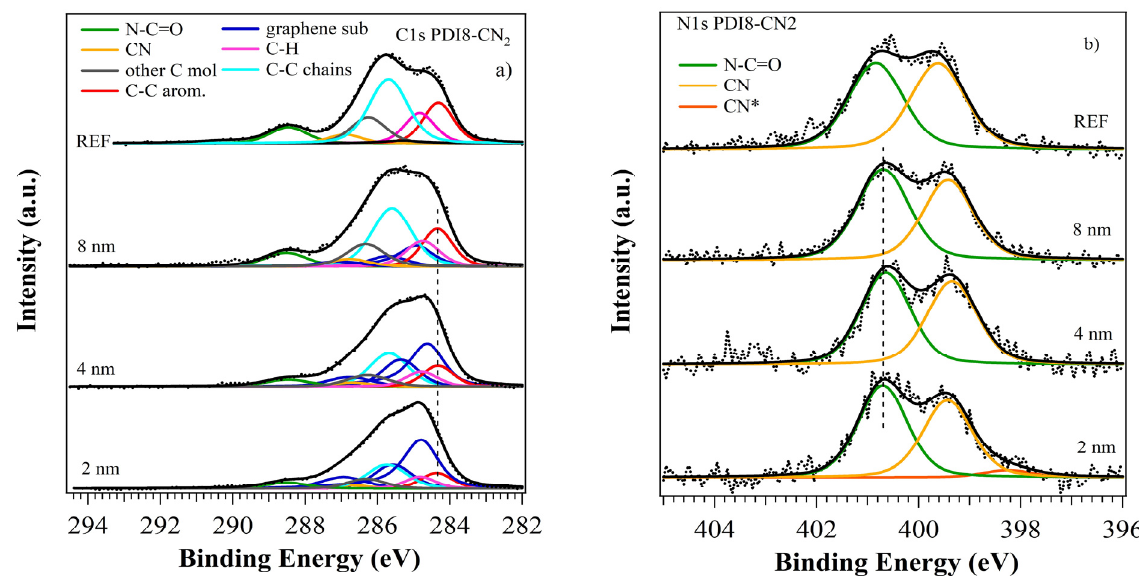
Figure 2. XPS analysis of the C1s ( a ) and N1s ( b ) core levels of the PDI8-CN2 film deposited on graphene, at different thicknesses. Spectra for the thick films are shown on the top for reference. The vertical lines suggest the absence of BE shifts for the main C1s and N1s molecular components.